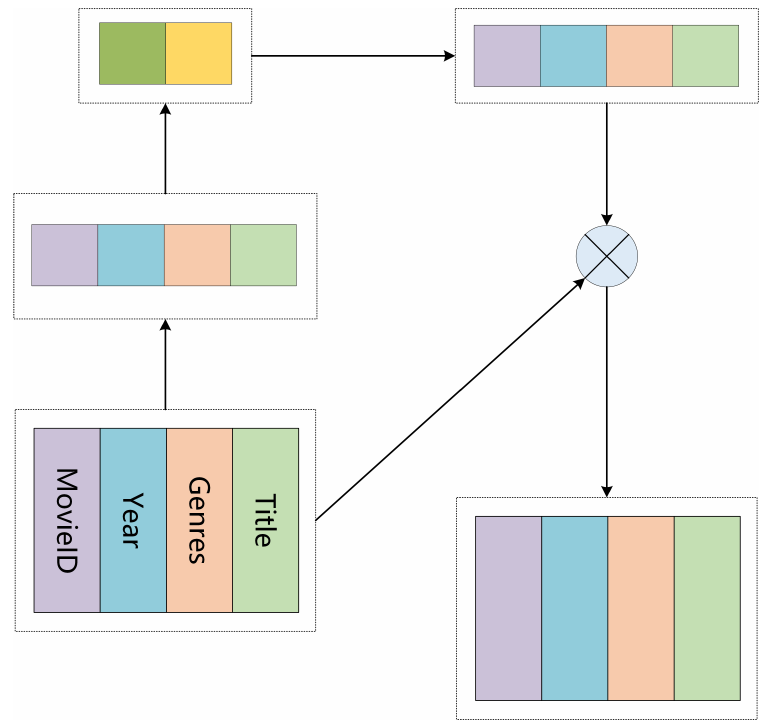
Figure 7. Calculation diagram of movie network